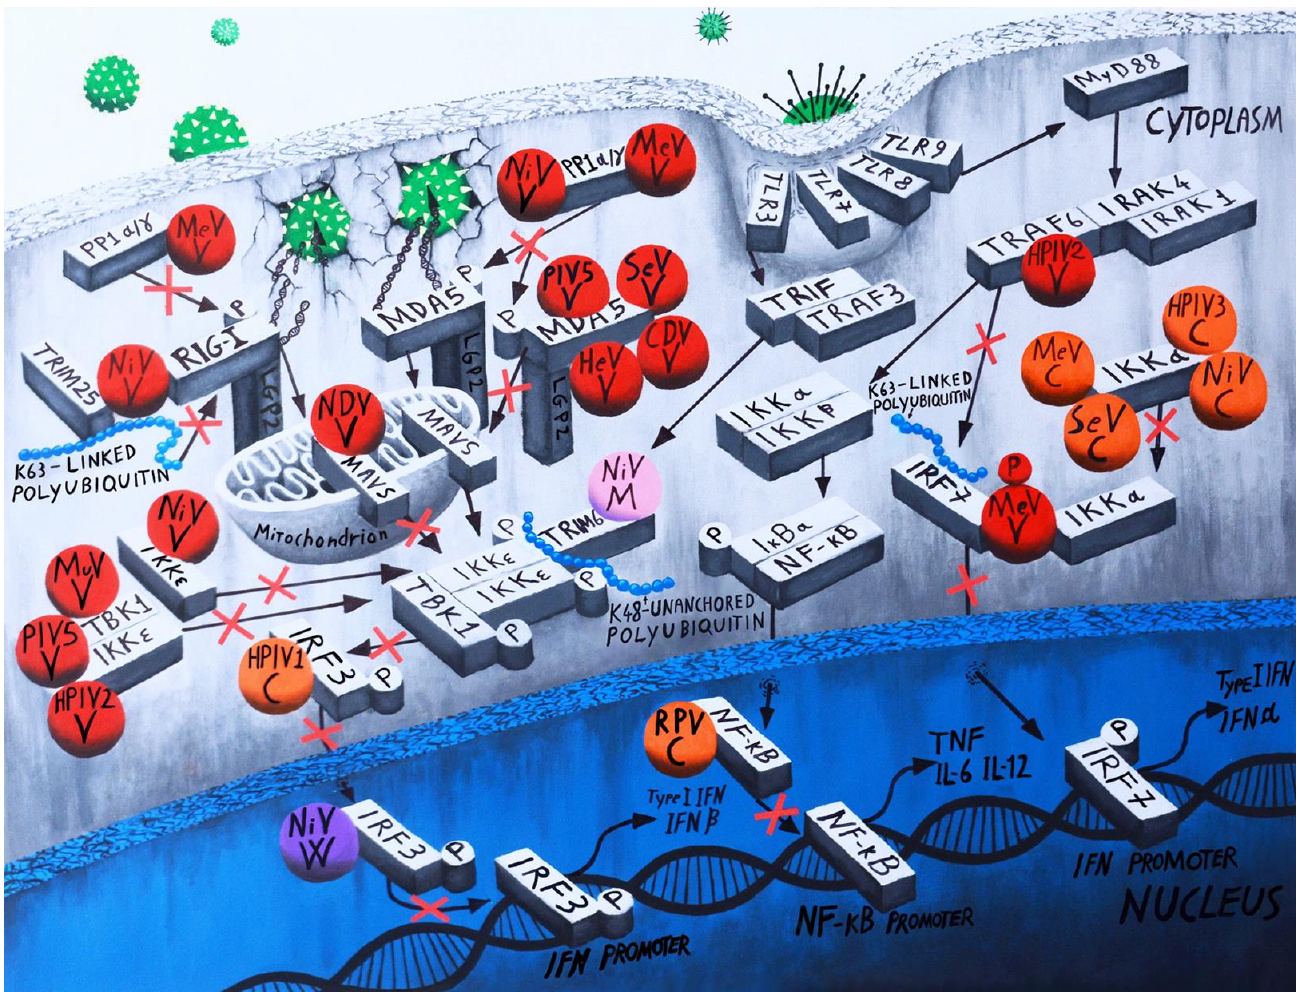
Figure 2. Antagonism of interferon induction by Paramyxoviriade . Once activated, MDA5 and RIG-I proteins undergo large conformational changes leading to the interaction with the mitochon- drial associated signaling protein (MAVS also known as IPS-, VISA, or CARDIF) through their caspase activation and recruitment domains (CARDs), which in turn leads to activation of a kinase complex composed in part of TBK-1 and IKK- ε that phosphorylates a latent cytoplasmic transcription factor interferon regulatory factor-3 (IRF-3). After homo-dimerization, IRF-3 translocates to the nucleus where it associates with nuclear factor κ B (NF- κ B) and activates transcription factor 2 (ATF2/c-jun) to drive IFN gene transcription. TLRs sensors activate distinct pathways, but converge with RLR, in phosphorylating IRF-3 or IRF-7, as well as nuclear factor κ B (NF- κ B), causing their translocation into the nucleus to activate the transcription of early type I IFNs (IFN β and IFN α ). Most of the paramyx- oviruses are able to neutralize the IFN induction pathway by targeting most of the transcription factors involved in it. Most of V proteins from paramyxovirus are represented in red, interacting with IFN induction transcription factors represented in light gray, while the viruses are represented in green with yellow or black spikes. LPMV V: La Piedad Michoac á n Mexico Virus V protein, MPRV V: Mapuera virus V protein, MuV V: Mumps virus V protein, PIV5 V: Parainfluenza virus 5 V protein, HPIV2-V: Human Parainfluenza virus 2 V protein, NDV-V: Newcastle disease